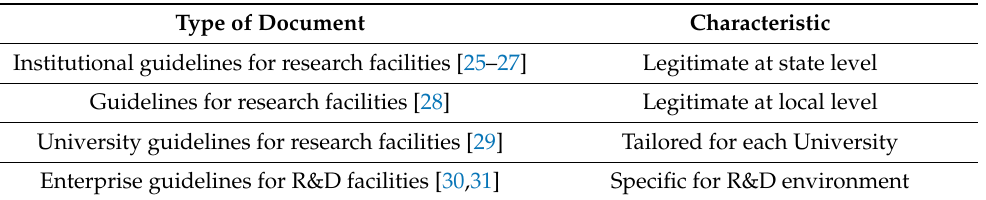
Table 4. Guidelines/reviews/analyses concerning COVID-19 risk in research labs.